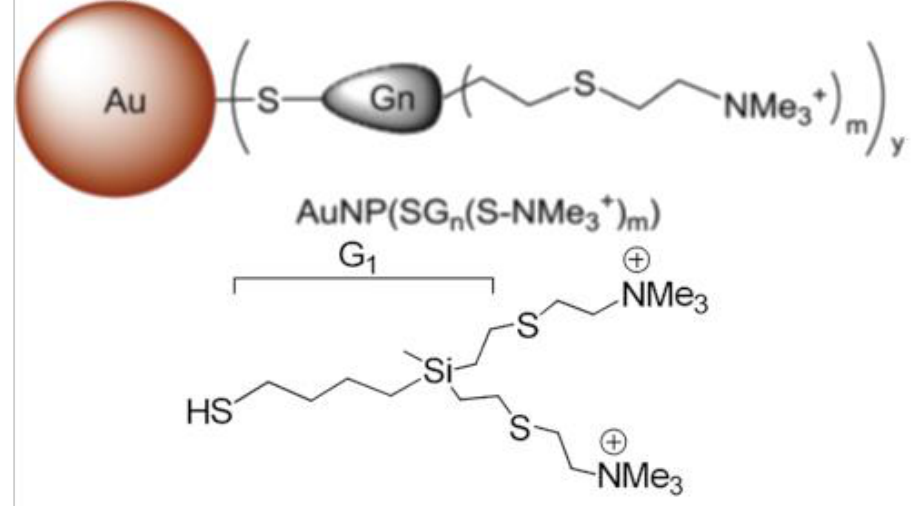
Figure 1. Structures of AuNPs. AuNP13, n = 1, m = 2; AuNP14, n = 2, m = 4; AuNP15, n = 3, m = 8. G n is dendron generation. Table 2. Physicochemical parameters of AuNPs.